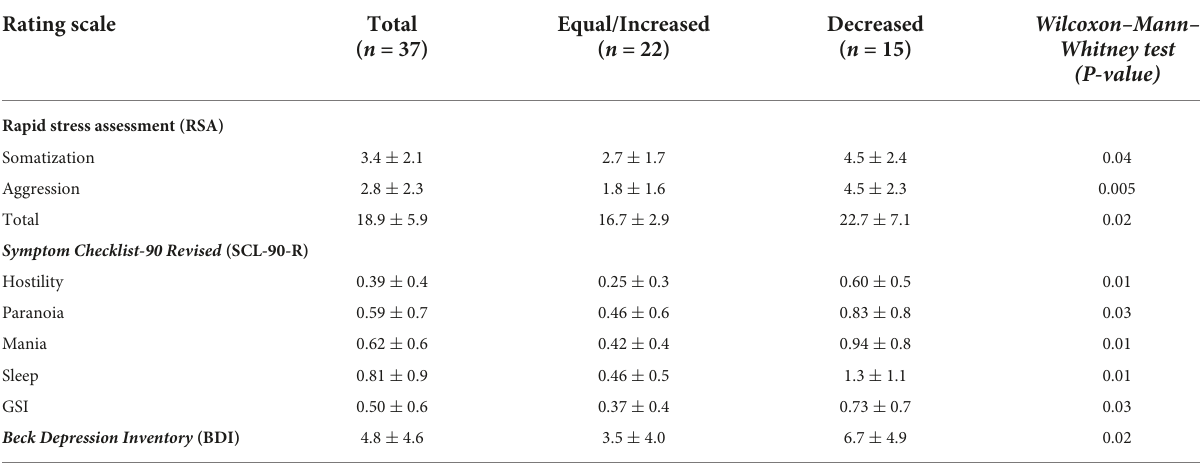
TABLE 4 Psychological distress comparisons between different participation in the organization of work at the earthquake and at the pandemic of intensive care unit (ICU) medical doctors ( n =